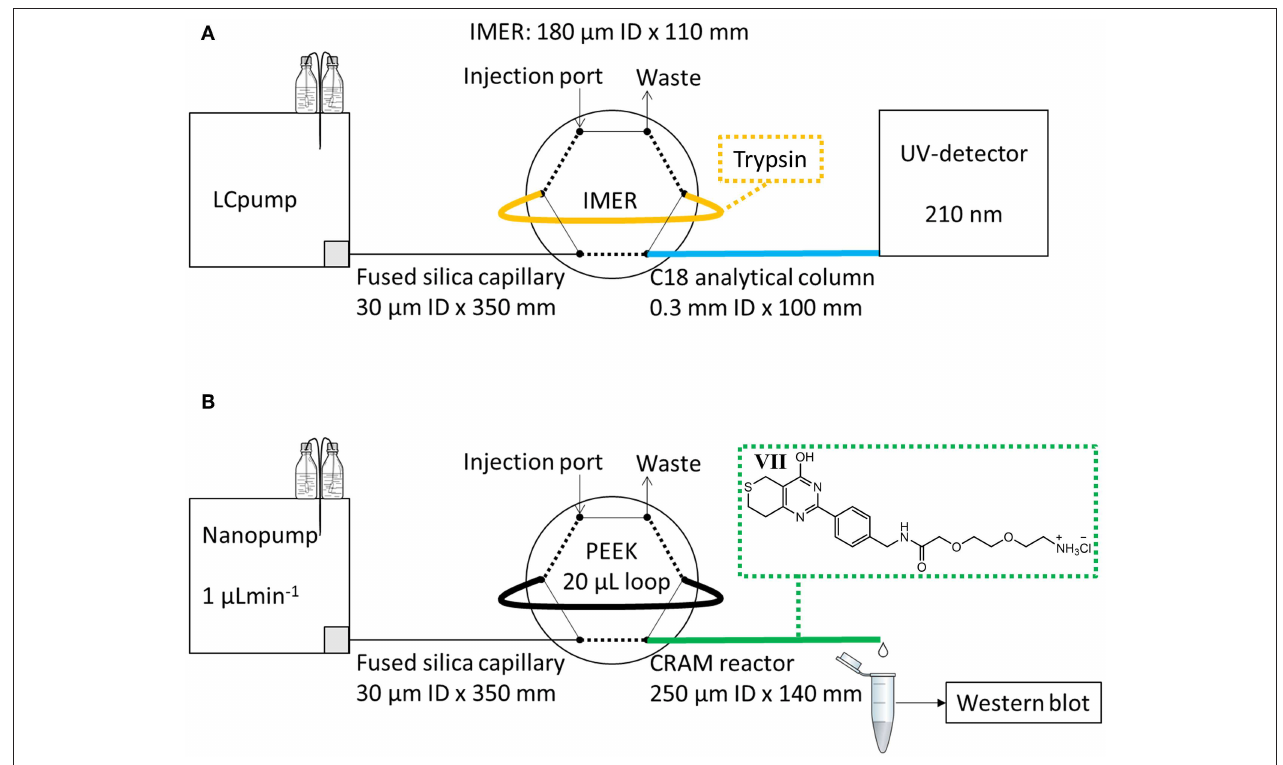
FIGURE 1 | Experimental set-up for evaluation of (A) IMERs with trypsin and (B) CRAM reactors with modified LDW639 ( VII